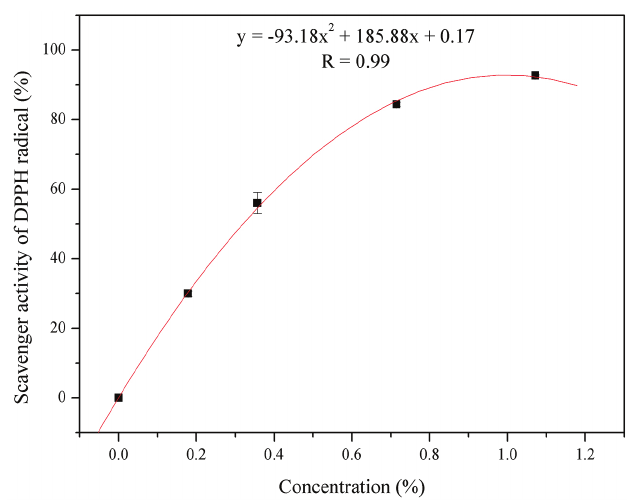
FIGURE 1 - Inhibition percentage of the DPPH radical versus concentration of the GB soft